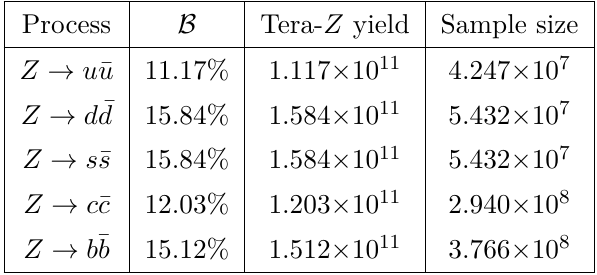
Table 2 . Branching ratios ( B ), expected yields at Tera- Z , and sample sizes actually used for exclusive Z → q ¯ q backgrounds.